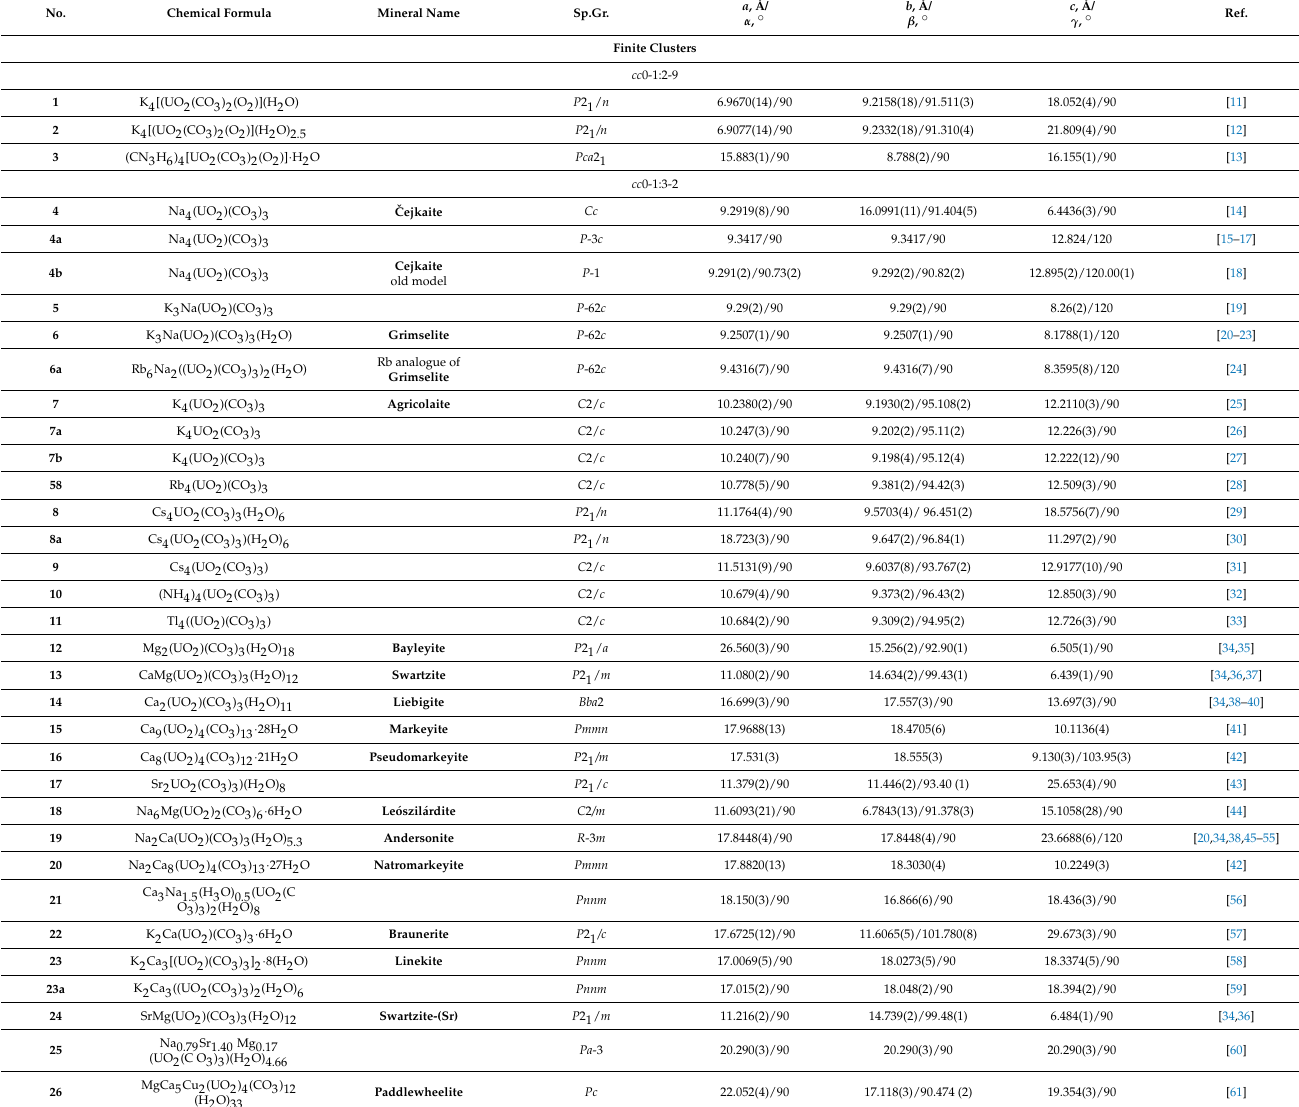
Table 1. Crystallographic characteristics of natural and synthetic uranyl